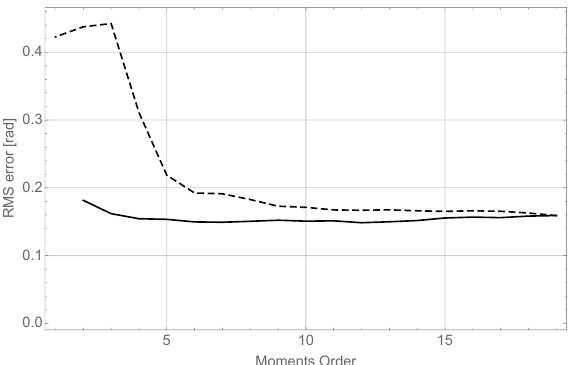
Figure 4. Results of the angle estimation tests. The dashed line shows varying moment order in θ while keeping orders in x and z constant in 19th, while the solid line shows varying moment order in x and z while keeping the 19th order constant in θ .